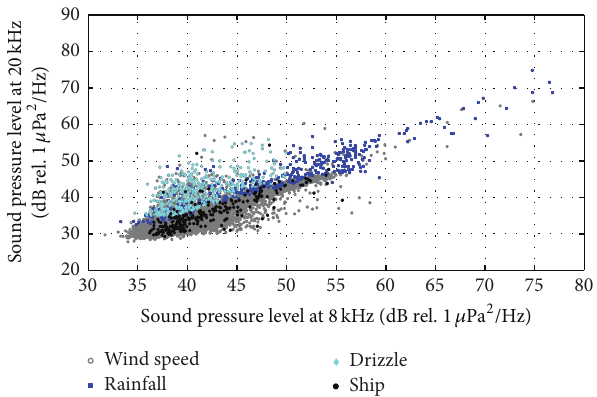
Figure 4: Scatter test of the 20 kHz versus 8kHz sound pressure levels acquired from June to September 2011. Different symbols refer to different types of phenomena or events as detected and estimated using Passive Aquatic Listener.